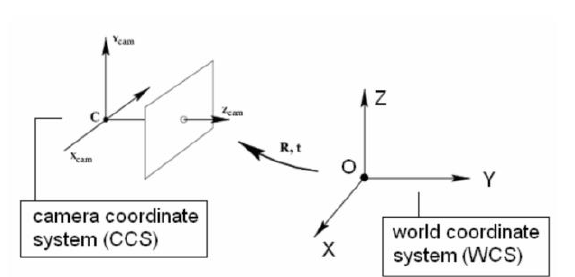
Figure 3. Transformation between world and camera coordinate system (Tola